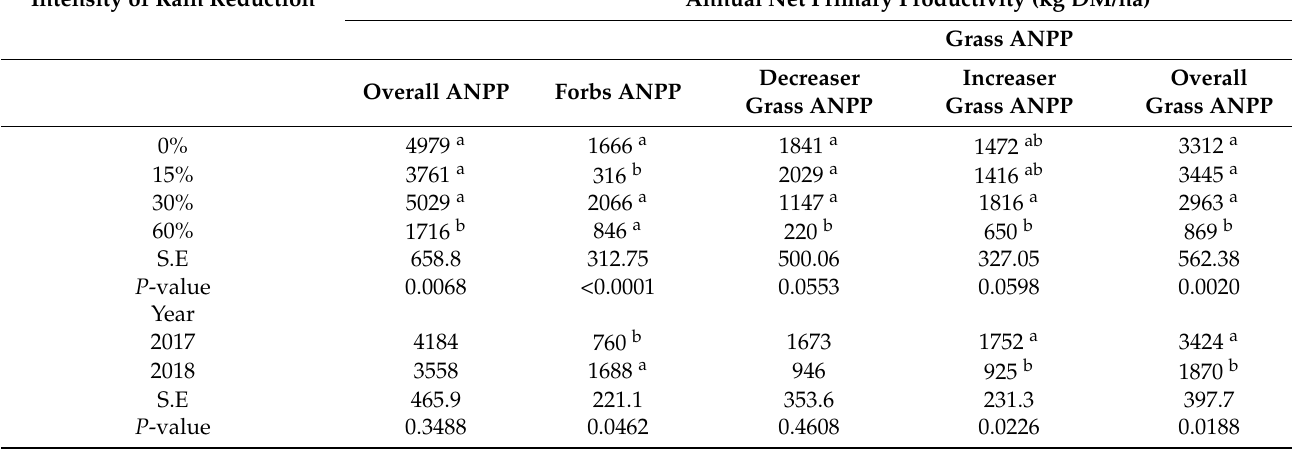
Table 3. Percentage (%) contribution of different functional groups in terms of annual primary productivity (ANPP) as affected by intensity of rainfall reduction (RR) in Pretoria.